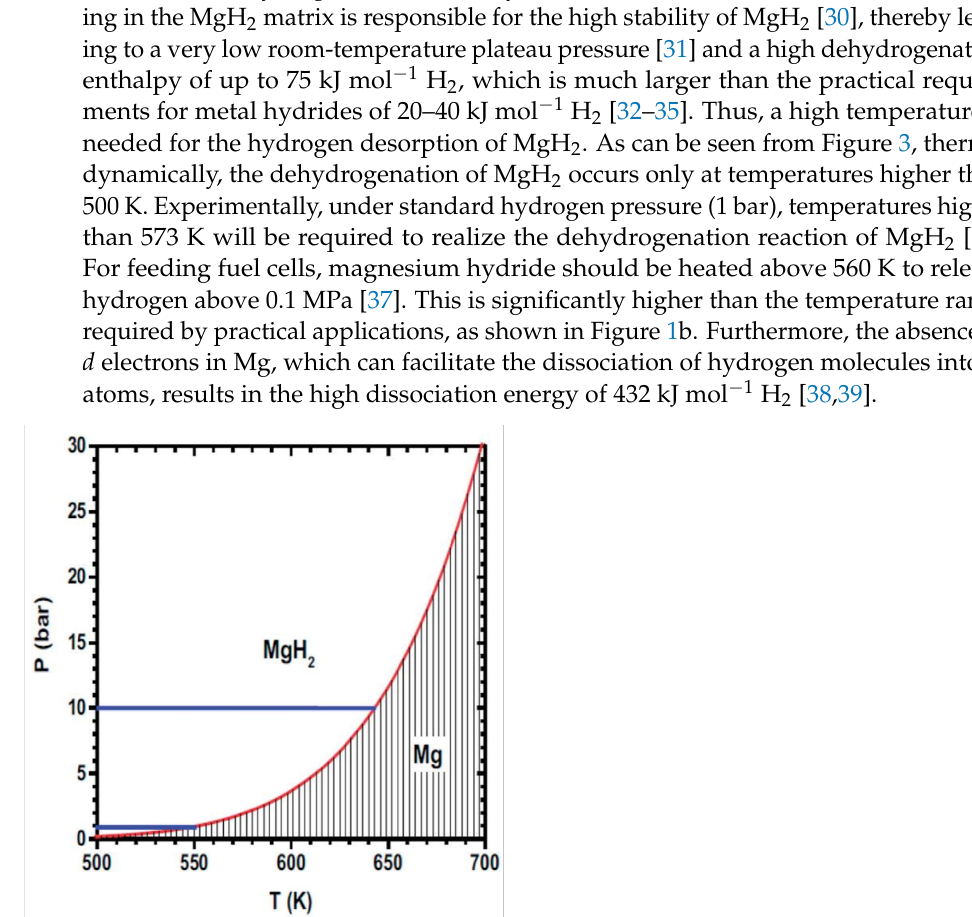
Figure 3. The variation of plateau pressure as a function of temperature for magnesium hydride. Reproduced with permission [33]. Copyright 2016, Springer